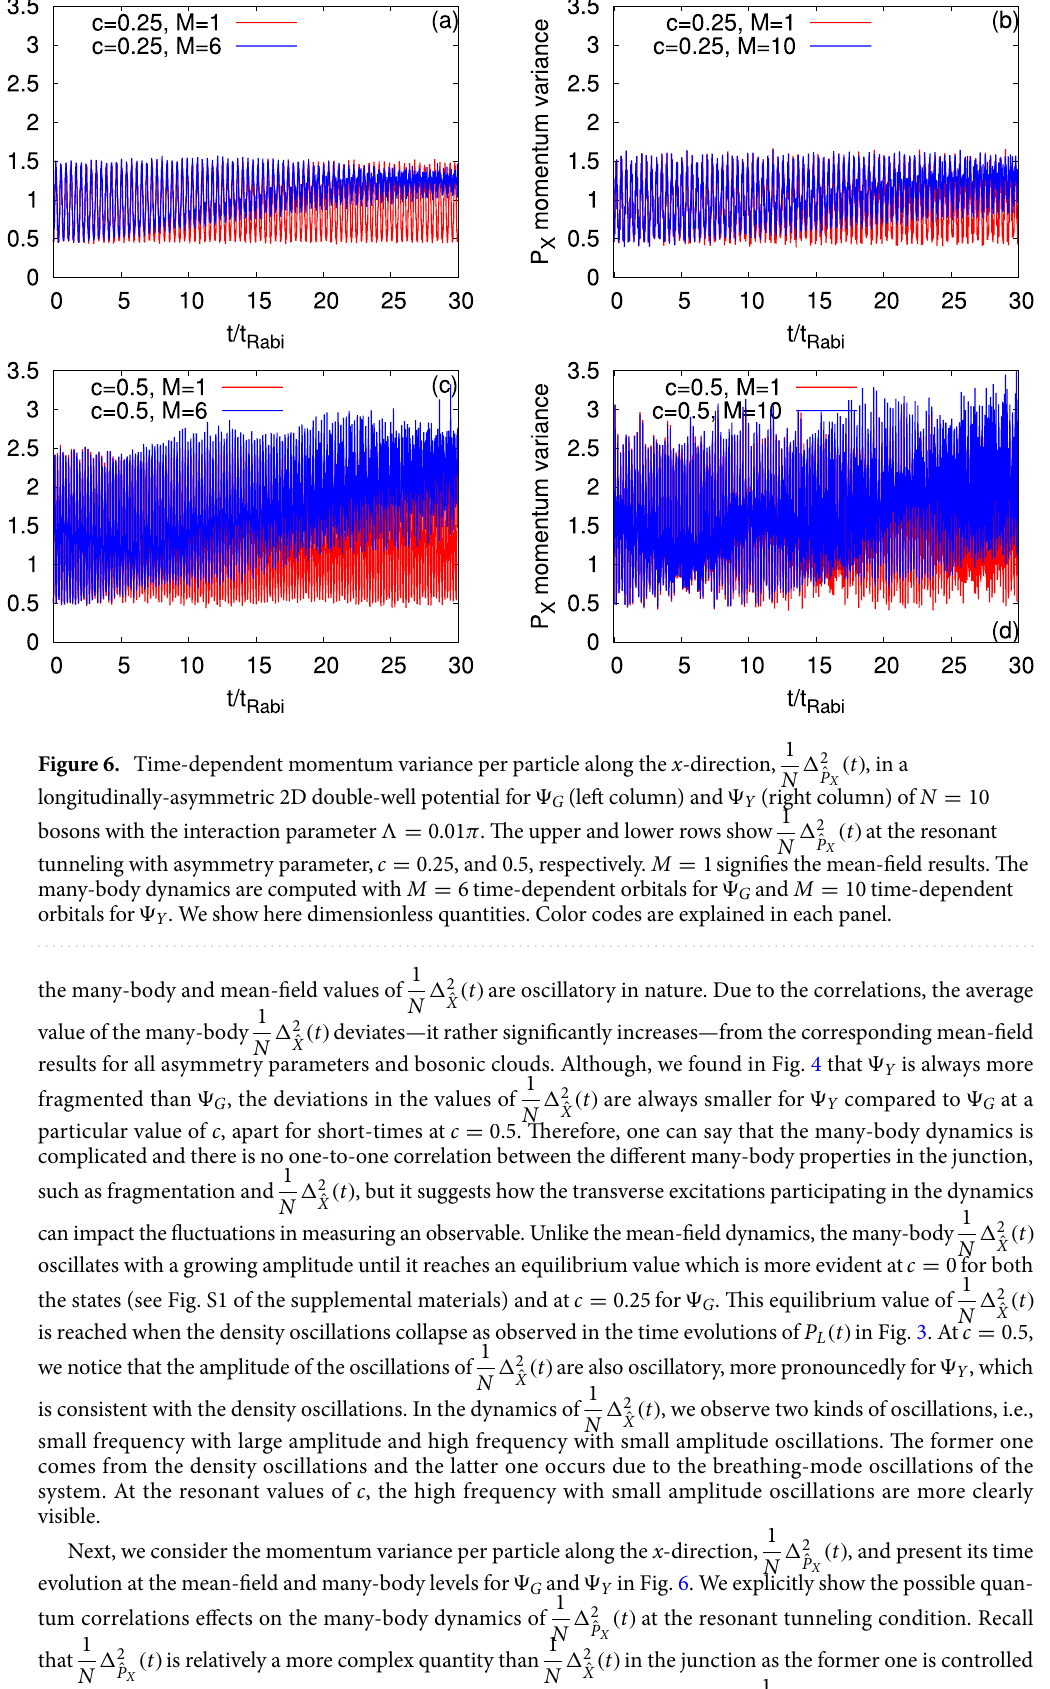
0.01 π . The upper and lower rows show = 0.25 , and 0.5, respectively. M = 6 time-dependent orbitals for (cid:31) G and M =